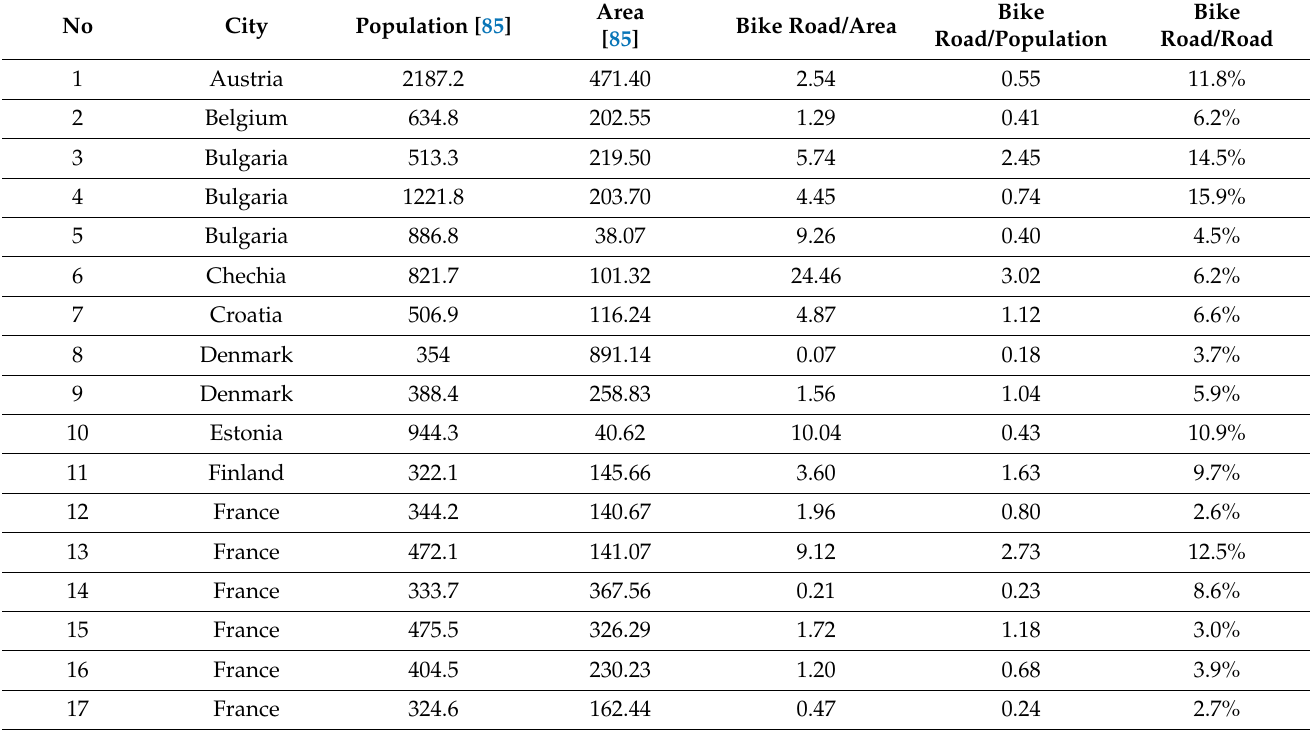
Table 3. Bike roads per area and the population in European Union smart cities that are best adjusted for